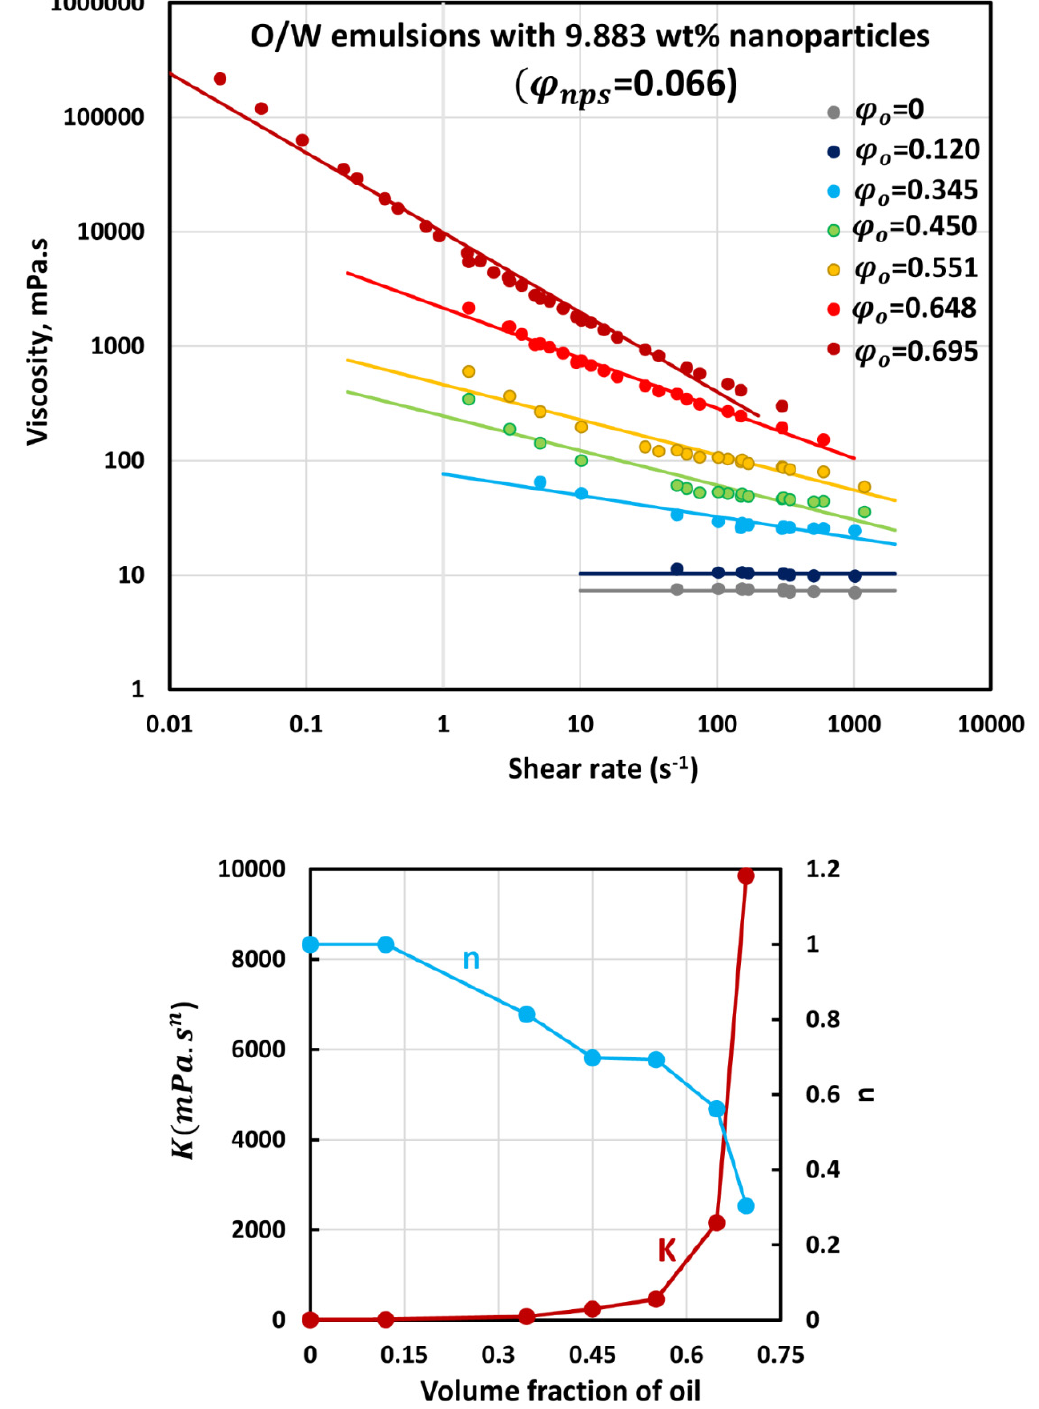
Figure 7. Flow behavior of O/W emulsions thickened with starch nanoparticles at nanoparticle concentration of 9.883 wt% ( ϕ nps = 0.066).